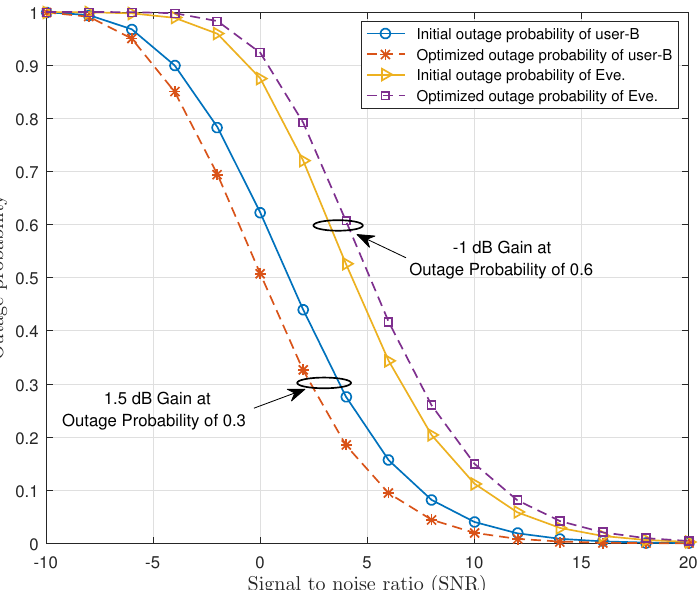
Figure 5. Comparison of outage probability of user-B and Eve before and after optimization versus SNR in